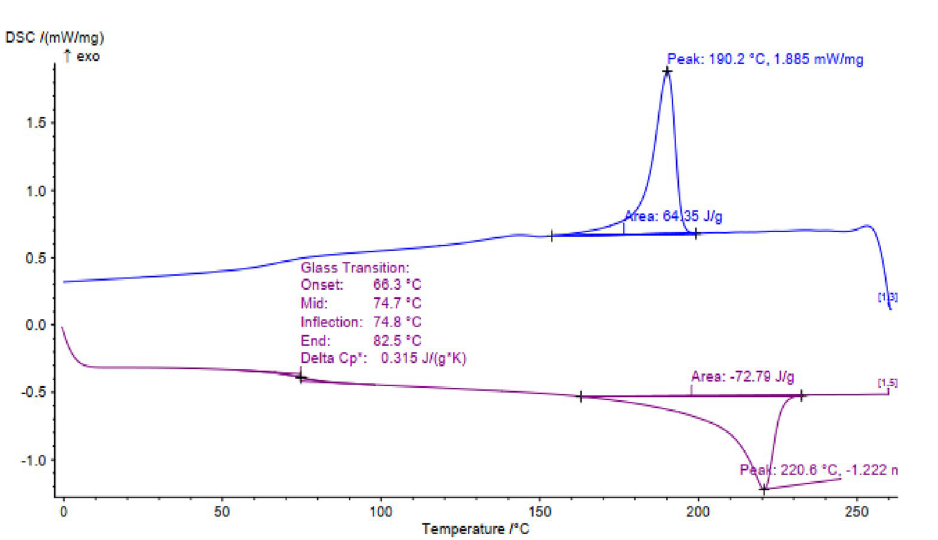
Figure 6. The reversible DSC analysis of the TiO 2 @PVA